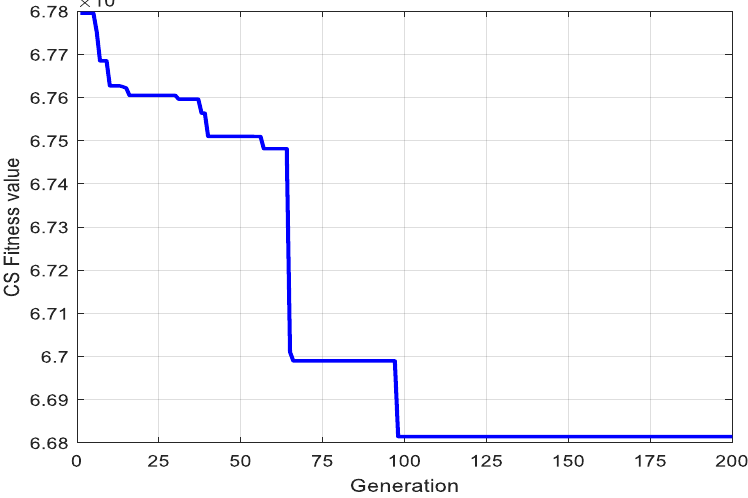
Figure 7. Behavior of the CS fitness value.